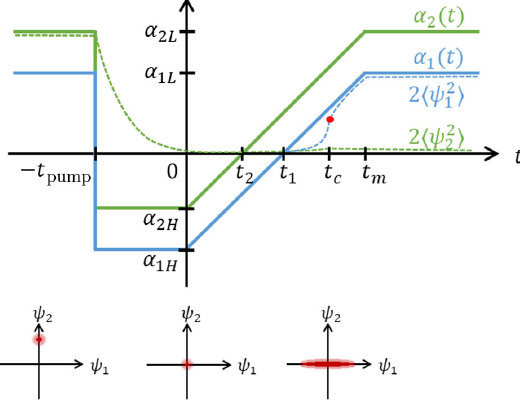
FIG. 2. Upper panel: Time evolution of quadratic free-energy t Þ (solid lines) and mean square values of order coefficients α i ð parameters (dashed lines). Different colors denote different orders. The pump maintains the system at a high temperature T < t < 0 , after which (negative α ¼ α ) for the time − t H iH pump the temperature relaxes to the equilibrium one T (positive L α ¼ α ) over a time t . Shown is the linear cooling profile used iL m to derive exact formulas in the slow cooling case. The mean-field order parameter is suppressed during the high-temperature stage. r Þ 2 i starts to grow exponentially Order parameter fluctuation h ψ i ð after t , as shown by the dashed curves. The red dot denotes the i point of crossover to nonlinear dynamics [ h ψ 2 1 i ∼ α 1 ð t Þ ] at time t . c Lower panel: The local order parameter probability distributions ρ ð ψ ψ 1 ; 2 Þ corresponding to the time intervals vertically